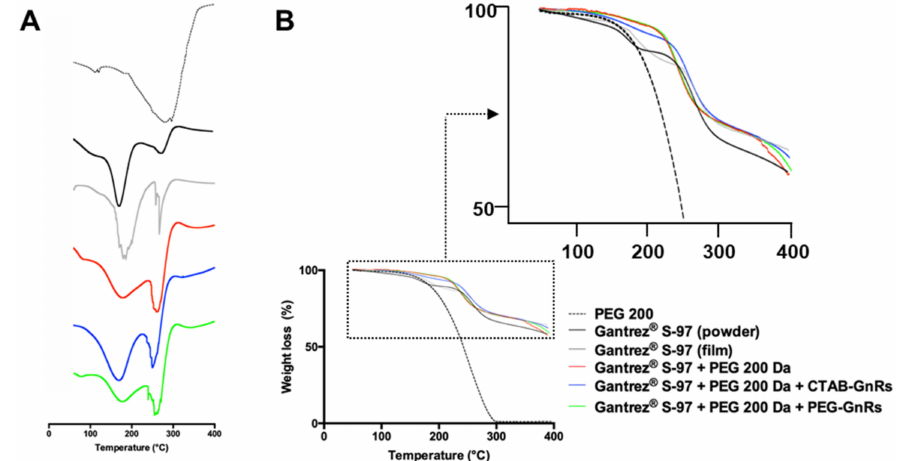
Figure 8. Thermal analysis of PEG 200 Da, Gantrez ® S-97, and crosslinked films made with CTAB and PEG-GnRs: Di ff erential scanning calorimetry (DSC) ( A ), thermogravimetric analysis (TGA) ( B